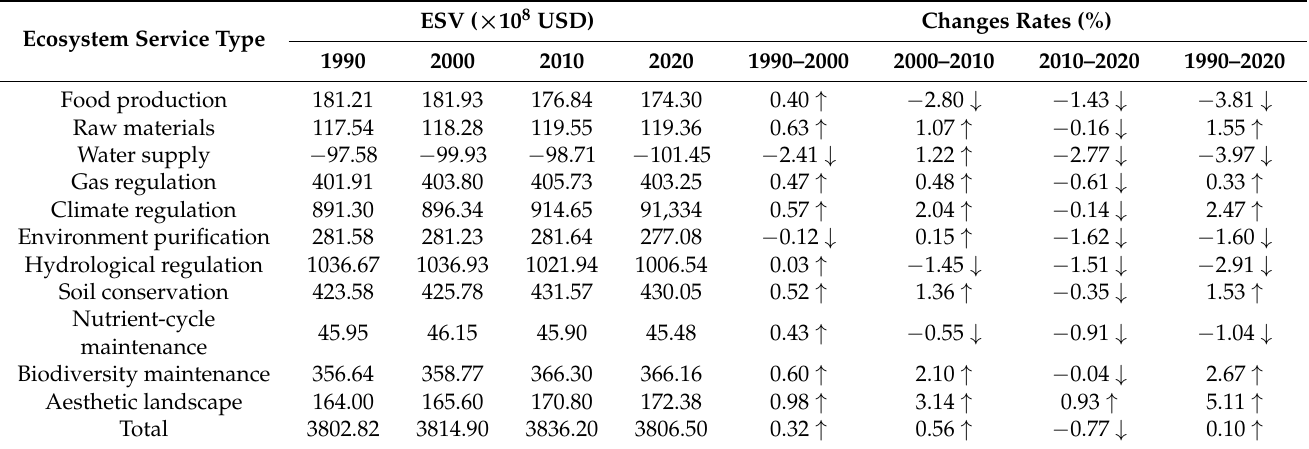
Table 6. Changes in different ESVs in Shaanxi Province from 1990 to 2020.